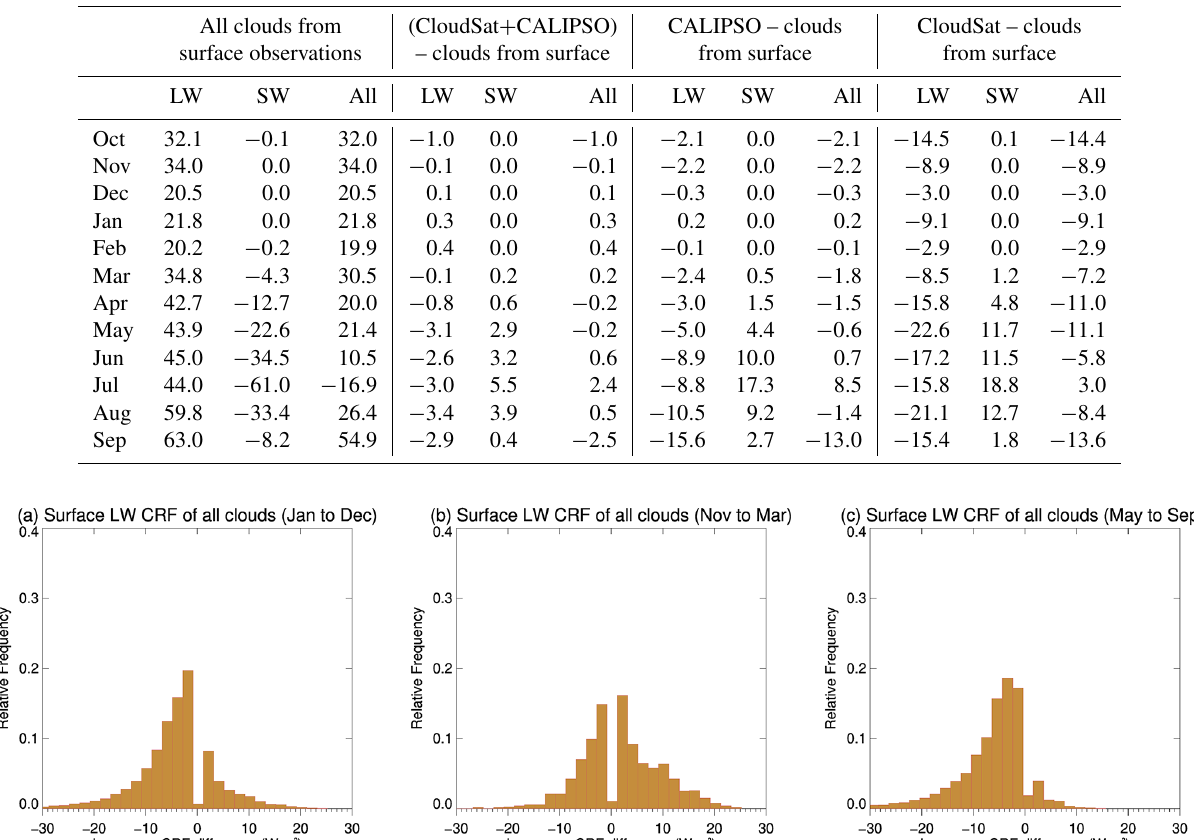
Table 1. Monthly mean CRF at the surface for longwave (LW), shortwave (SW), and the combined LW and SW (all) with the clouds from the surface observations collected during the SHEBA experiment and the differences between the CRF with clouds in the surface observations only identified from combined CloudSat and CALIPSO, CALIPSO, or CloudSat and the CRF from the clouds from the surface observations. All clouds from